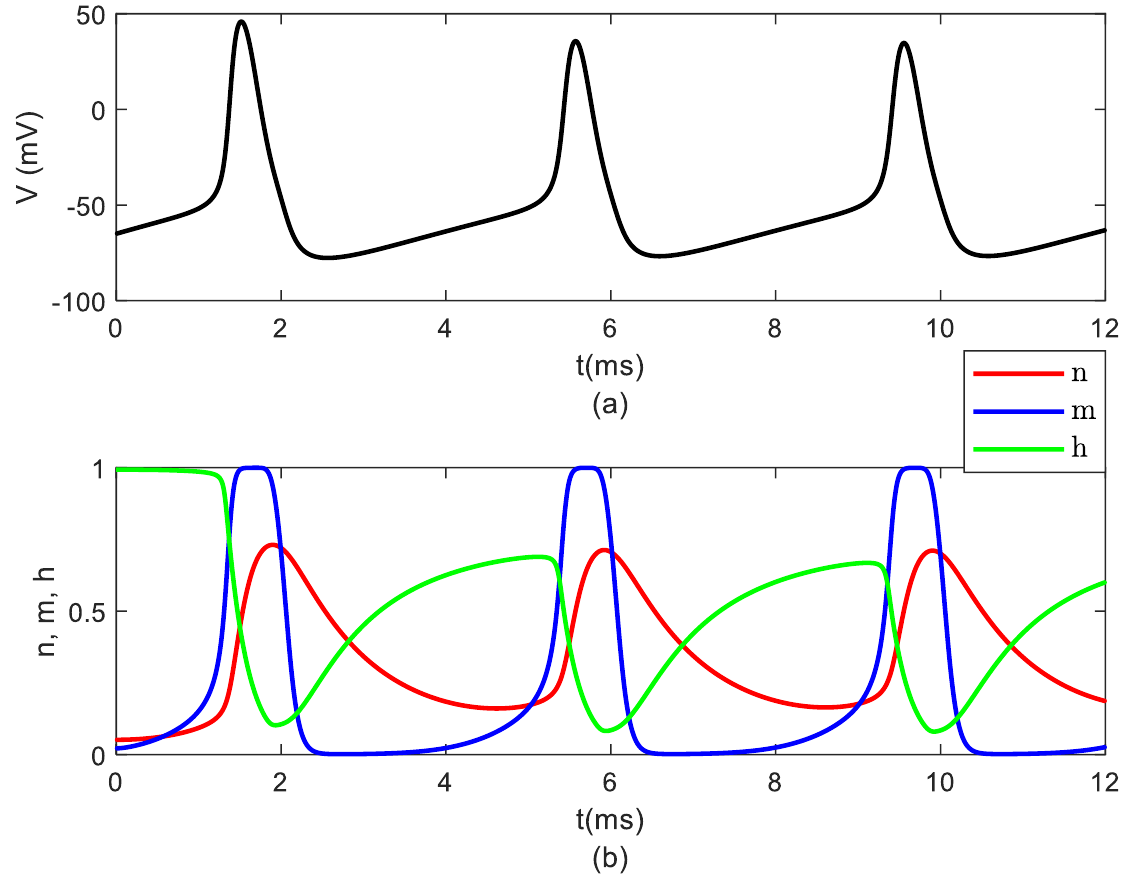
Figure 4. Time variations of (a) voltage 𝑽(𝒕) , and (b) gating variables 𝒏(𝒕), 𝒎(𝒕), and 𝒉(𝒕) , obtained by solving the modified Hodgkin-Huxley Equation